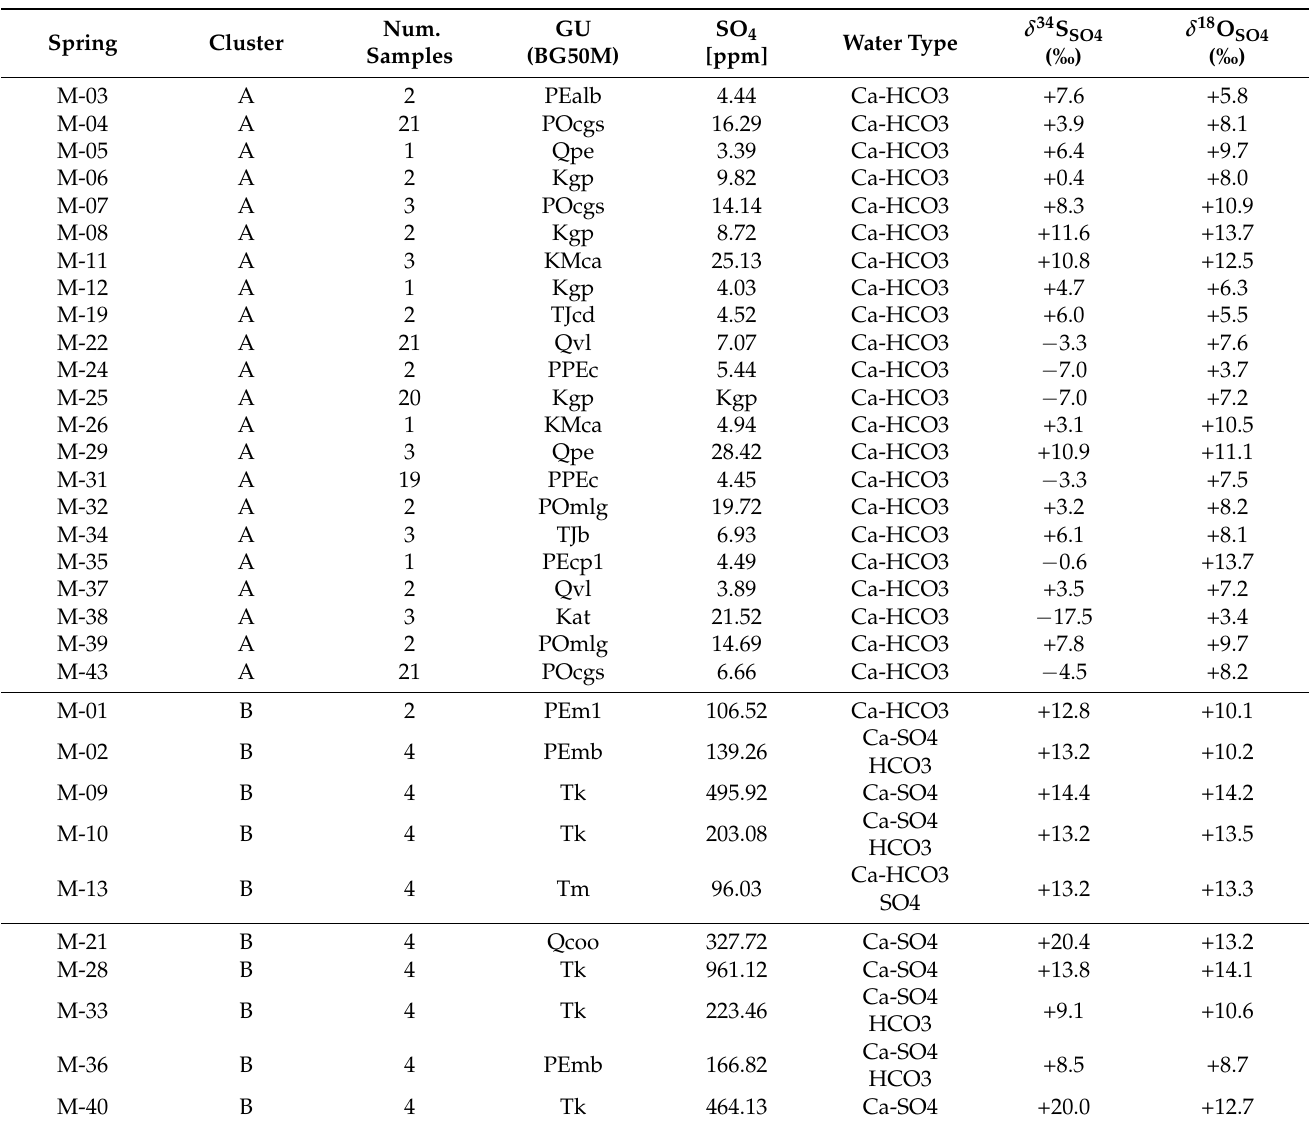
Table A6. Average values for δ 34 S SO4 and δ 18 O SO4 of samples available of all springs and the corresponding average SO 4